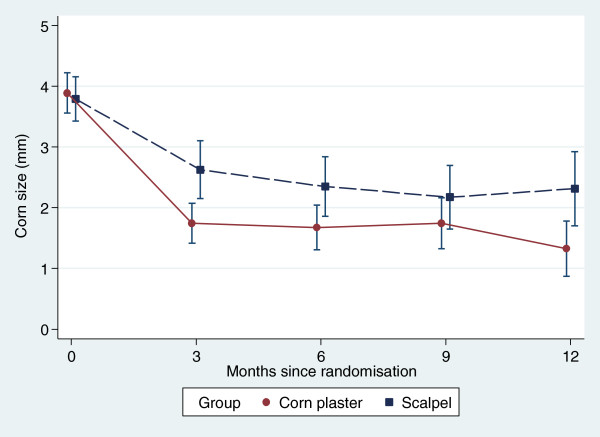
Corn size at different time points (means and standards errors).